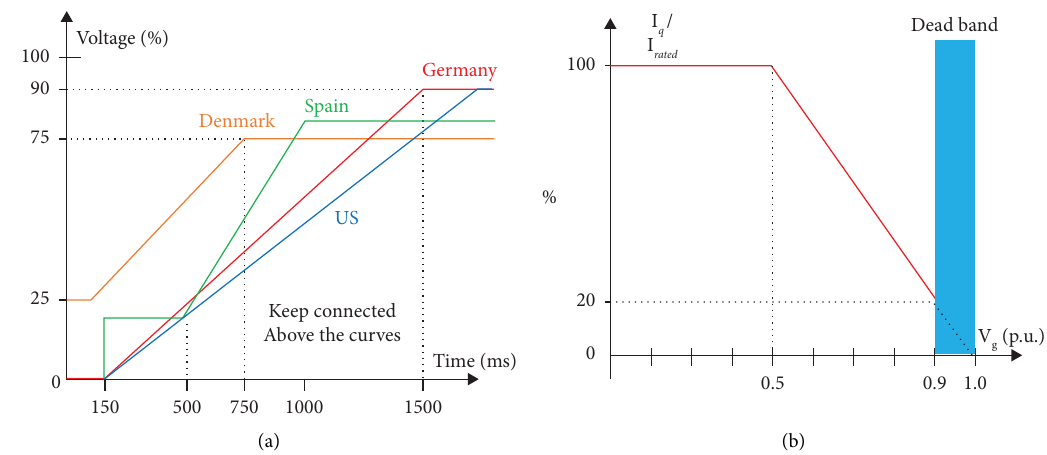
Figure 3: GC requirements that consist of (a) ride-through curve of diferent codes and (b) support curve of reactive current [60].